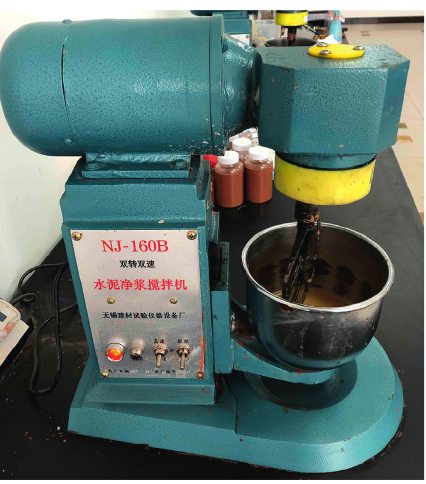
Figure 4: NJ-160B mortar mixer.